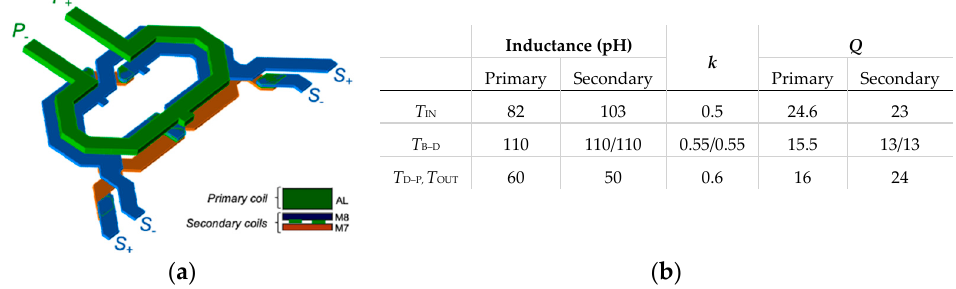
Figure 4. ( a ) Power splitter transformer, T B–D . ( b ) Electrical parameters of transformers at 77 GHz.